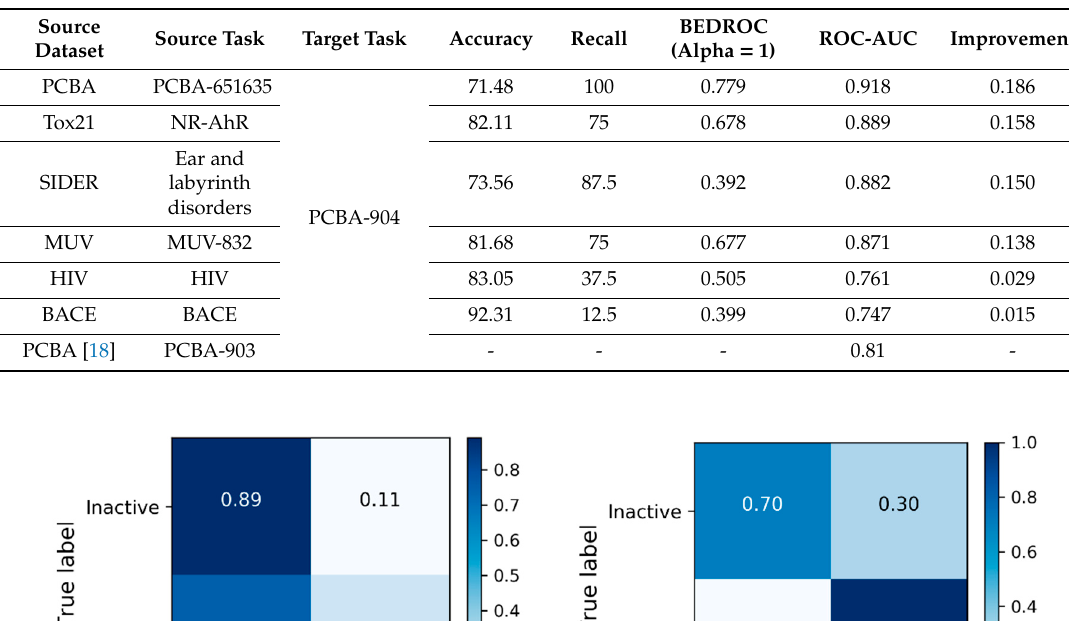
Table 4. Best performing source models for transfer learning on the target test dataset.